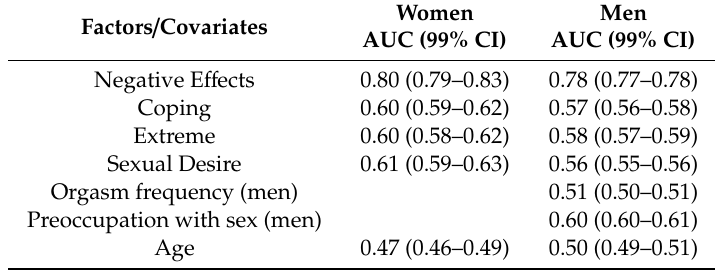
Table 4. AUC values and 99% confidence intervals of factors and covariates for experiencing the need for help for